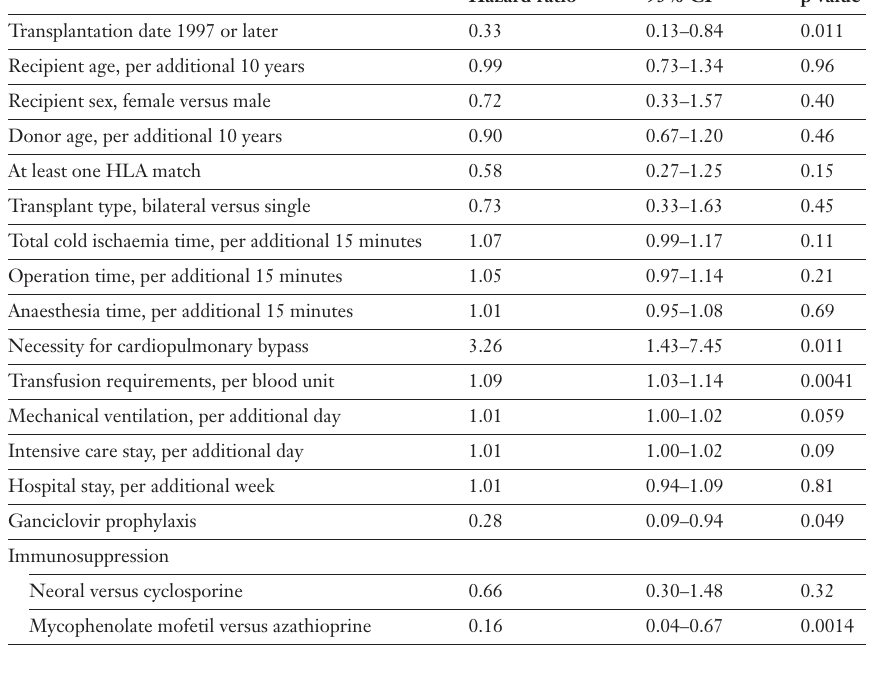
Time period effect adjusted for potential explanatory